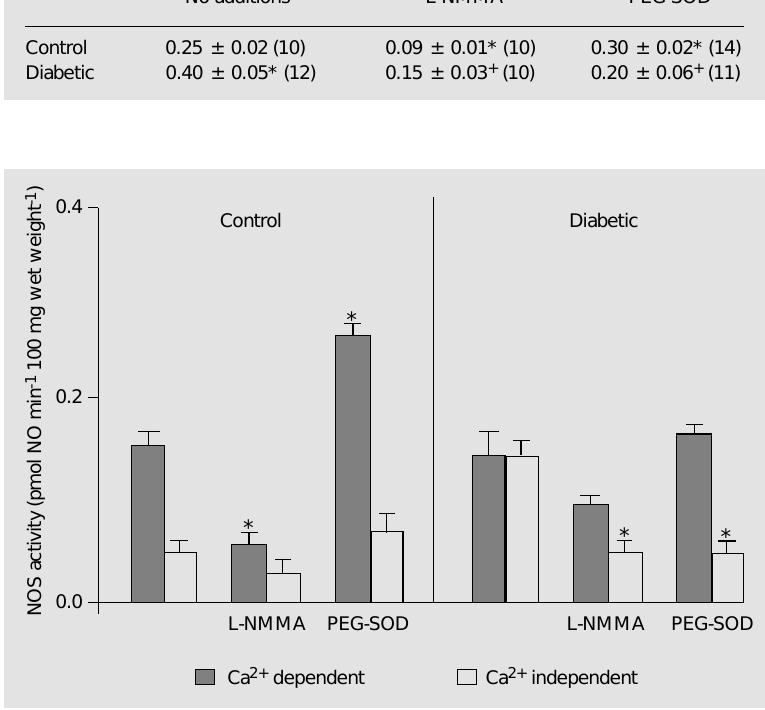
Figure 2 - Influence of PEG-SOD on pancreatic nitric oxide synthase (NOS) activity. NOS activity (Ca 2+ dependent and Ca 2+ independent) in pmol nitric oxide (NO) min -1 100 mg wet tissue -1 , from isolated control (N = 6) and diabetic (N = 8) rat pancreas incubated alone or in the presence of 600 µM L-NMMA or 1 U/ml PEG-SOD. Conditions and details as in legend to Figure 1. *P<0.05 vs basal levels from tissues incubated alone (ANOVA and Tukey- Kramer multiple